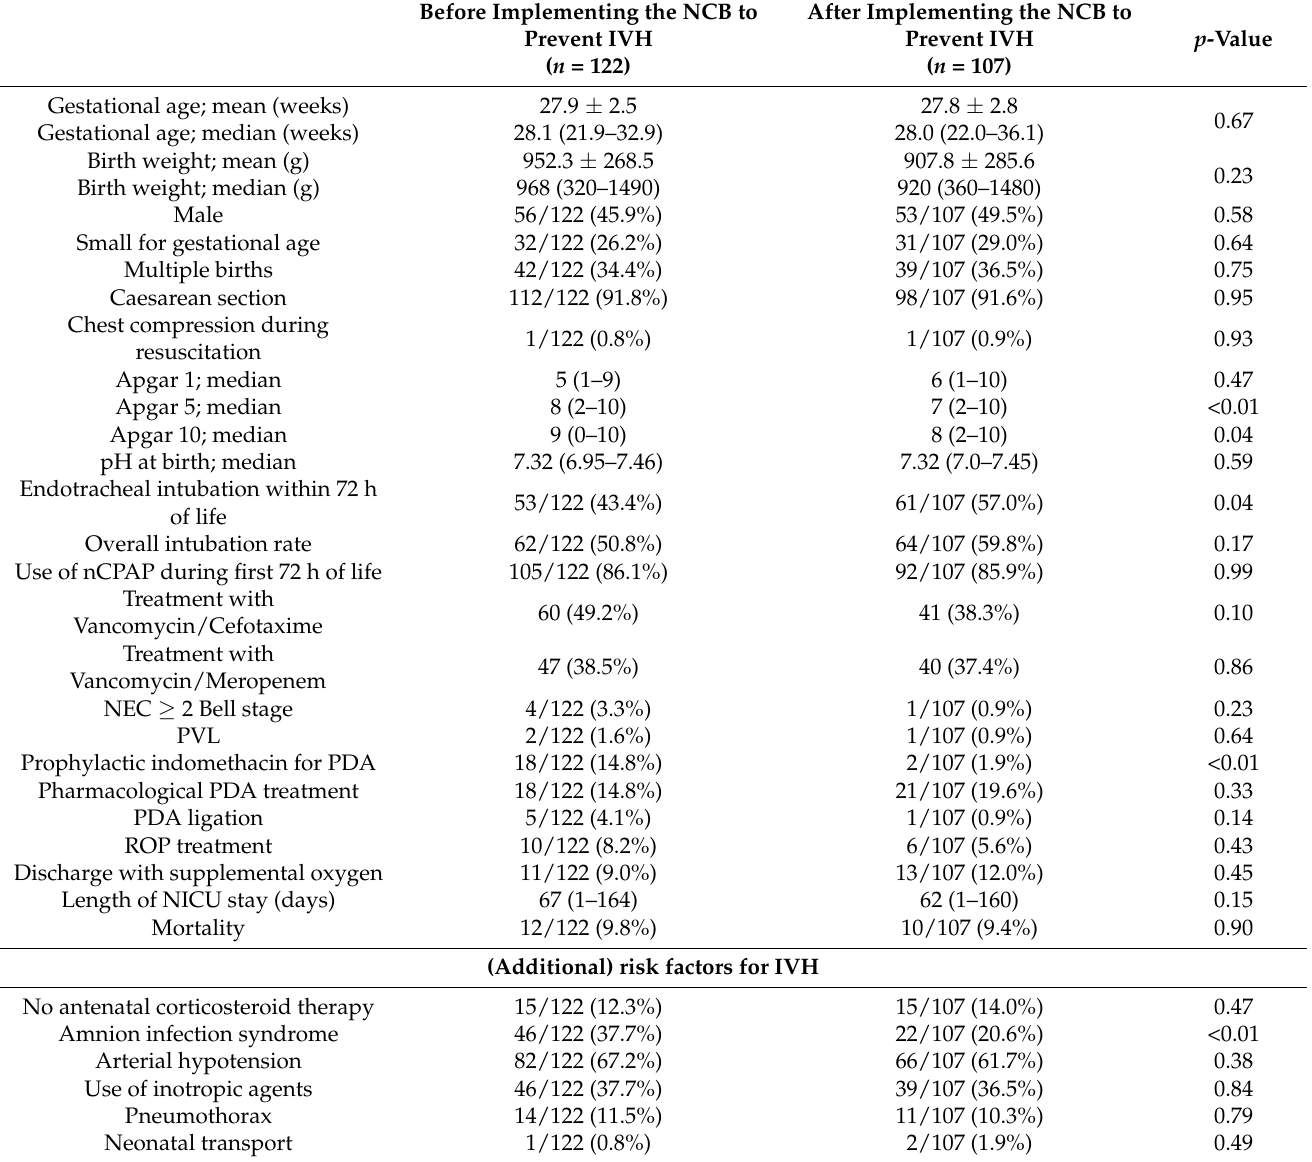
Table 2. Basic patient data and risk factors for